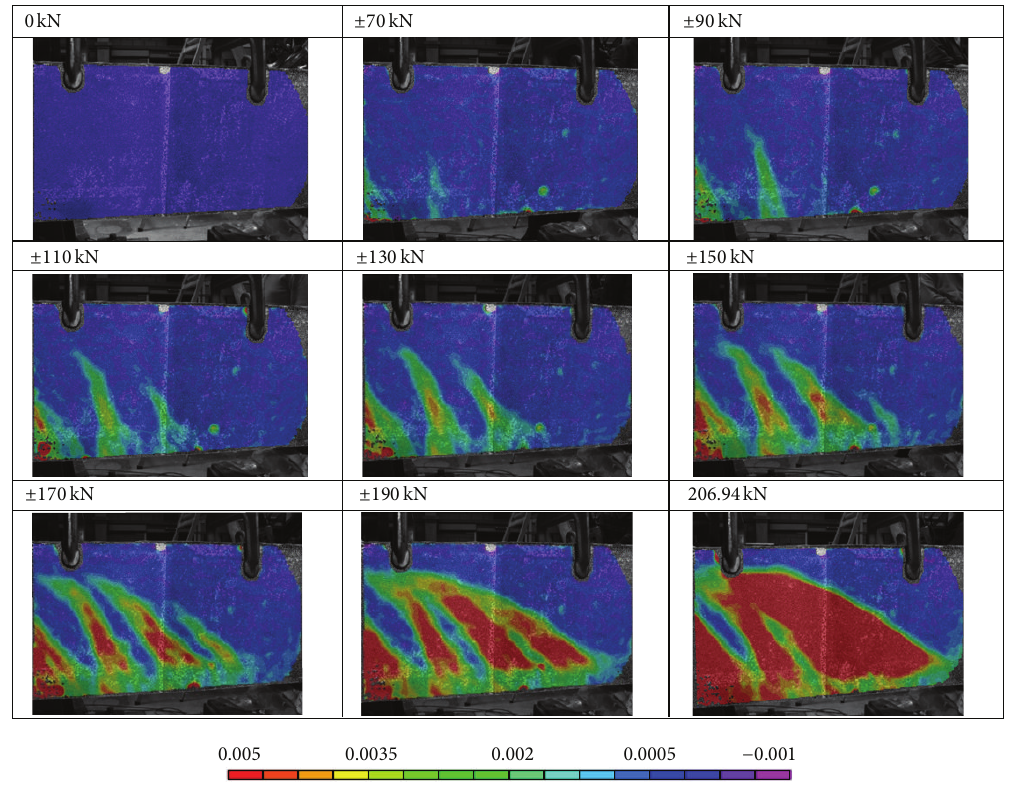
Figure 8: Fracture evolution composite